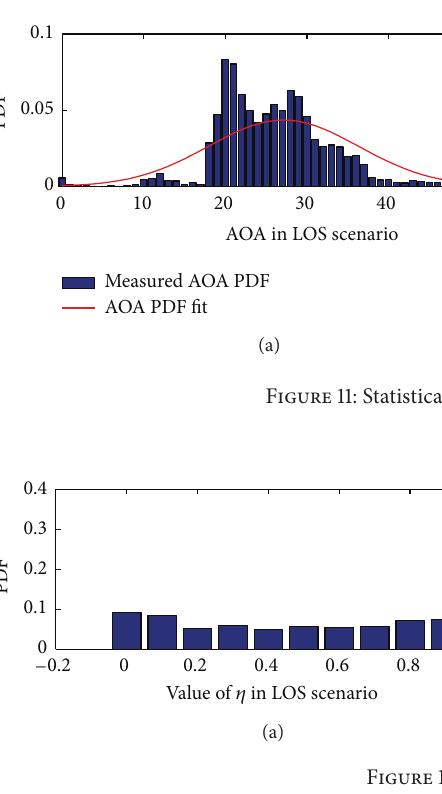
Figure 12: PDF of 𝜂 in LOS and OLOS section.